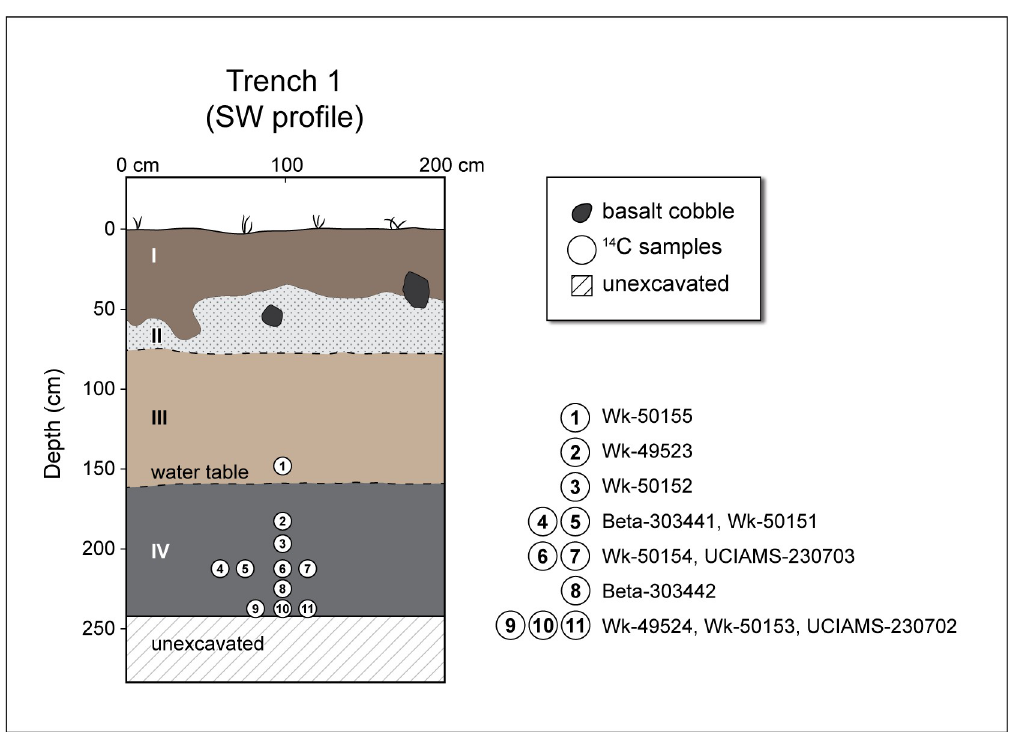
Fig 3. Stratigraphic profile of Trench 1, Ho‘oumi Beach, showing the location of the eleven radiocarbon samples.